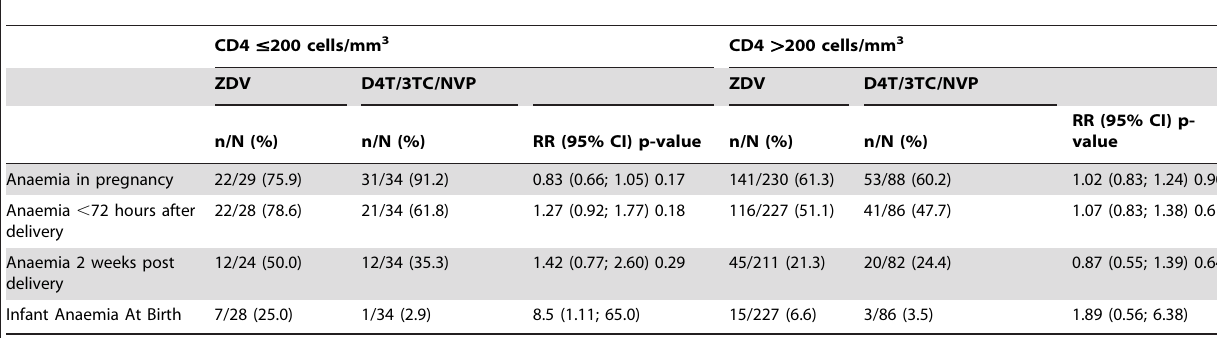
Table 3. Anaemia in Association with Antiretroviral Use and HIV Disease Stage (CD4 Count , 200 cells/mm 3 ).